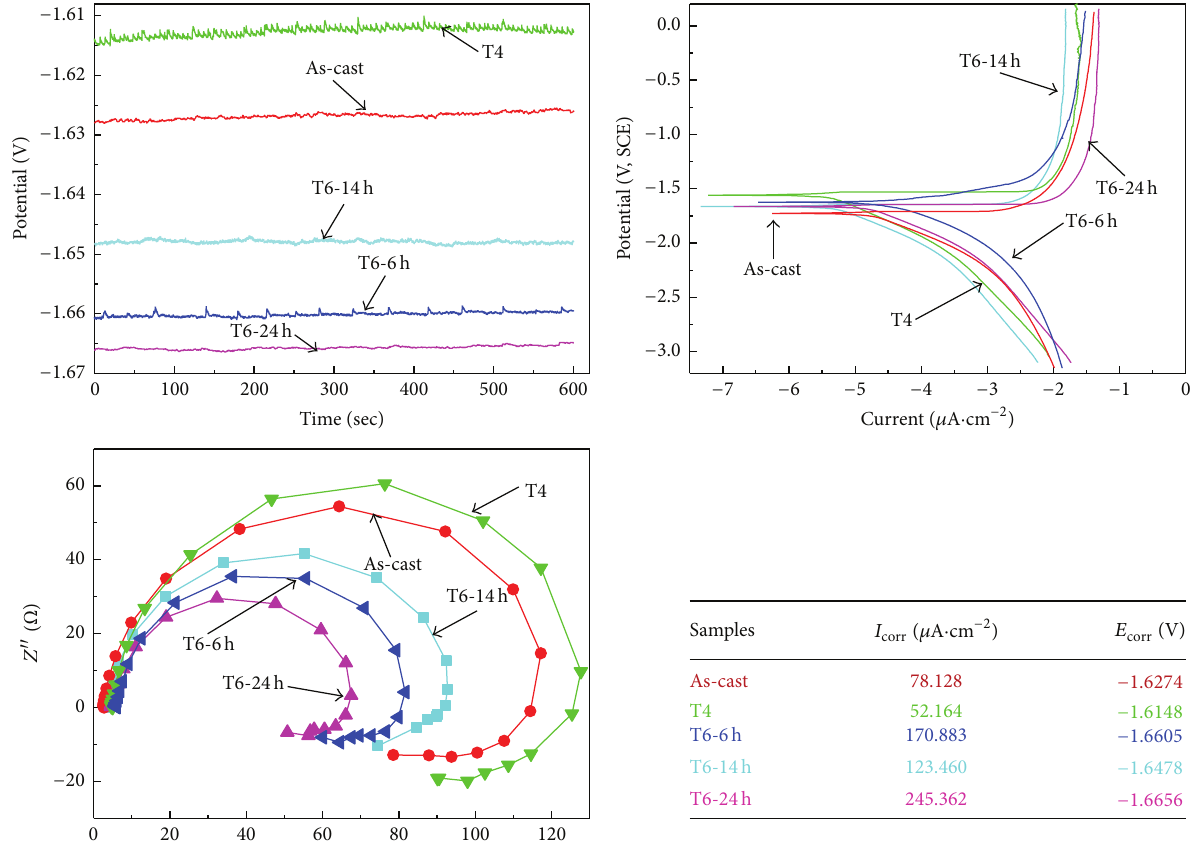
Figure 7: The electrochemical characterizations, corrosion potential ( 𝐸 corr ), and corrosion current ( 𝐼 corr ) of Mg-5Y-1.5Nd alloy measured in 3.5% NaCl